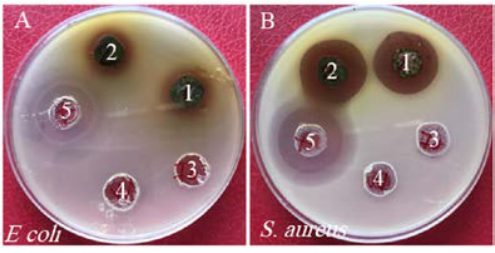
Fig. 2. The inhibition zone of rosemary leaves extracts against E. coli (A) and S. aureus (B) . 1 = 200 ml dilution of the leaves extract, 2 = 300 ml dilution of the leaves extract, 3 = 200 ml 70% ethanol, 4 = distilled water as a negative control, 5= 1.2 μg/ml of Streptomycin. Table 2. Numbers of polymorphic and monomorphic loci of each Rep-PCR primer and percentage of polymorphism in both bacteria that treated with different concentrations of rosemary leaves extracts Primer Total